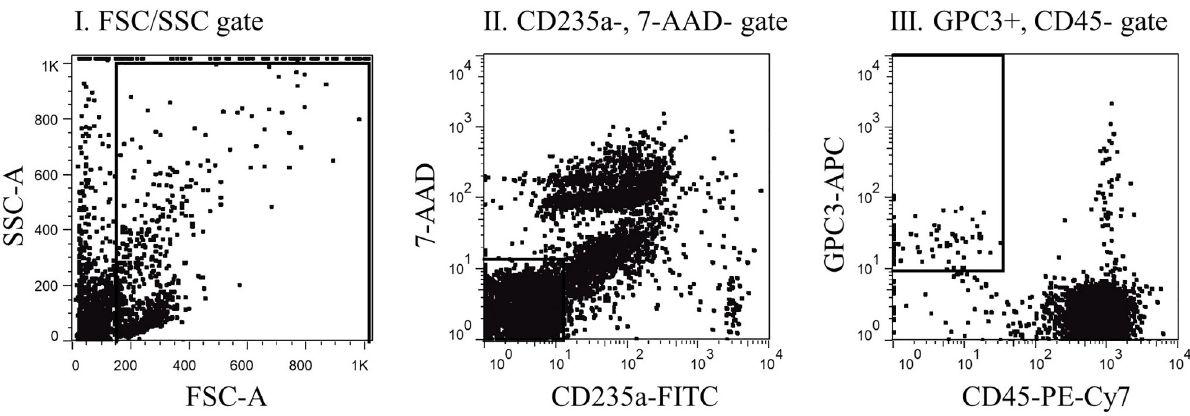
Fig 2. Gating strategy. The first step represents the forward-scatter (FSC) versus side-scatter (SSC) plot (left). In this step, the unassigned events and artifacts (including cell debris, mechanical noise, and cell clumps) are gated off. In the second step, the dead cells and CD235a-positive cells are gated off on the CD235a versus 7-AAD plot (middle). In the remaining CD45-negative cells, GPC3-positive cells are selected with the CD45 versus GPC3 plot (right).